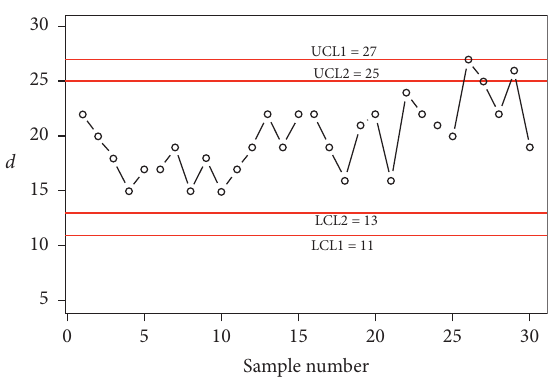
Figure 3: The Birnbaum–Saunders chart based on the MDSS method for simulated data. Table 8: The plotting statistic for the coupon data. Subgroup